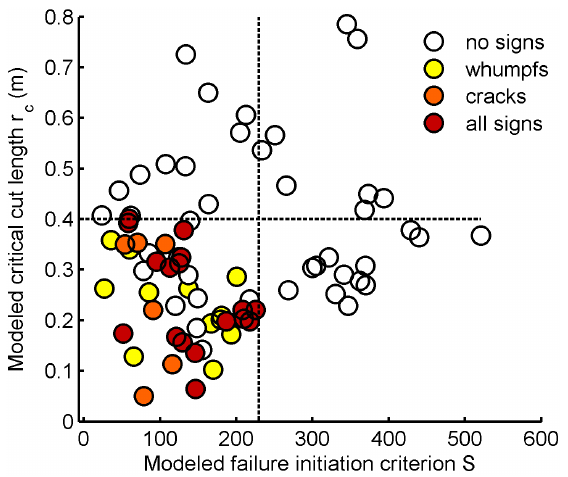
Figure 9. Type and presence of signs of instability against failure initiation criterion S and critical crack length r c , both modeled, for data sets A and B, if reported ( N = 77). Colors indicate type of observed signs of instability: whumpfs, shooting cracks with or without whumpfs (cracks) or all signs (whumpfs, cracks and recent avalanches observed). Open circles indicate that no signs of insta- bility were reported explicitly (no signs). Dashed lines represent split values dividing the plot into four quadrants as found with a classification